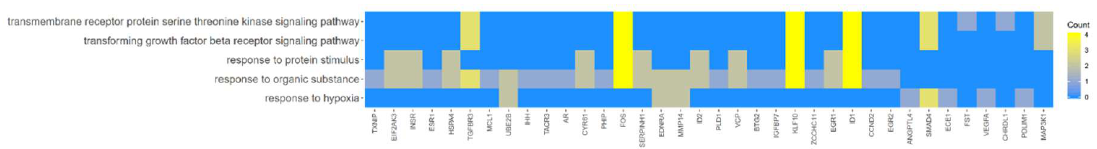
Figure 3. The representation of the mutual relationship between differently expressed genes that belong to the response to hypoxia, “response to organic substance”, “response to protein stimulus”, the “transforming growth factor β receptor signaling pathway”, and “transmembrane receptor protein serine threonine kinase signaling pathway” GO BP terms. The ribbons indicate which gene belongs to which categories. The middle circle represents logarithm from fold change (LogFC). The genes were sorted by logFC from most to least changed gene. The color of the each LogFC bar corresponds with LogFC value.